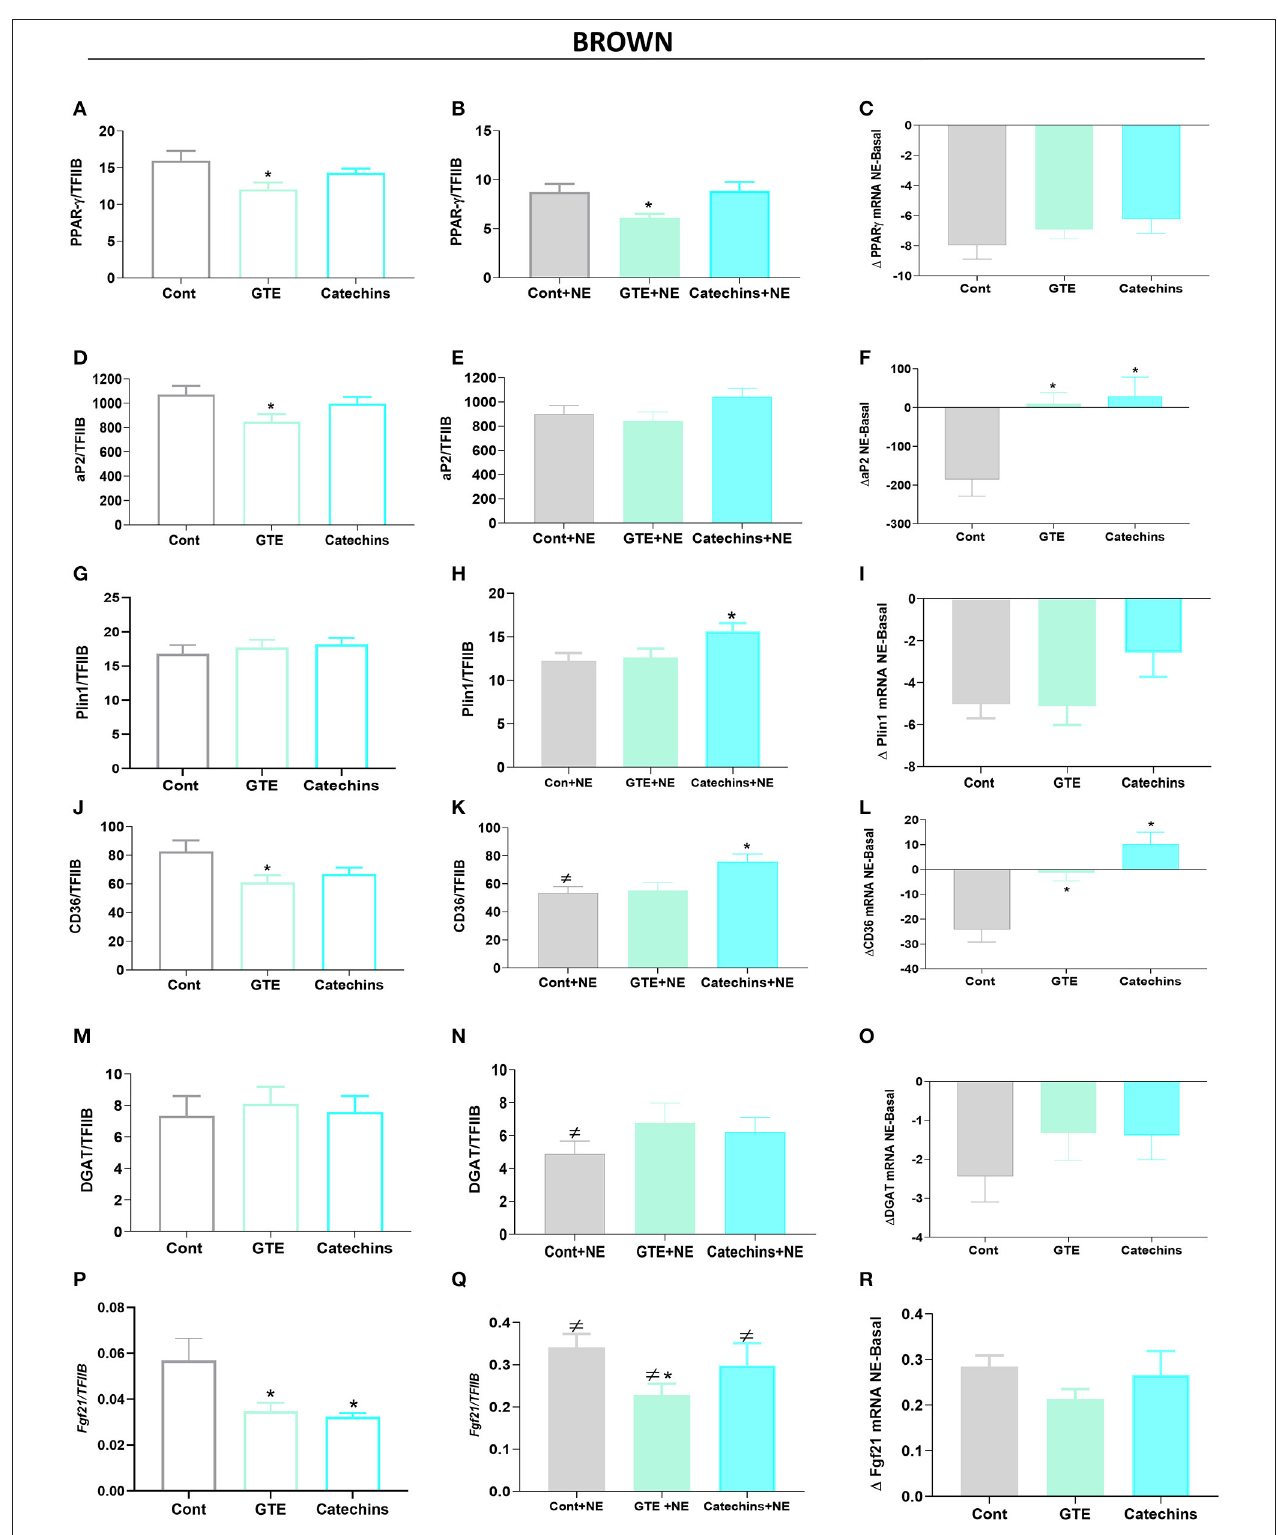
FIGURE 3 | Effect of green tea compounds on expression of genes associated with lipid metabolism in brown adipocytes. The brown adipocytes in Figures 1 , 2 were further analyzed for the expression levels of genes associated with lipid metabolism. PPAR γ mRNA levels in basal (A) and NE-stimulated (B) states, and the norepinephrine-induced change (C) . (D–F) results for aP2 ; (G–I) results for Plin1 ; (J–L) results for CD36 ; (M–O) results for DGAT ; (P–R) results for Fgf21 . The results are means ± SEM of five independent experiments, each performed in duplicate. Statistics are as in Figure 1 .